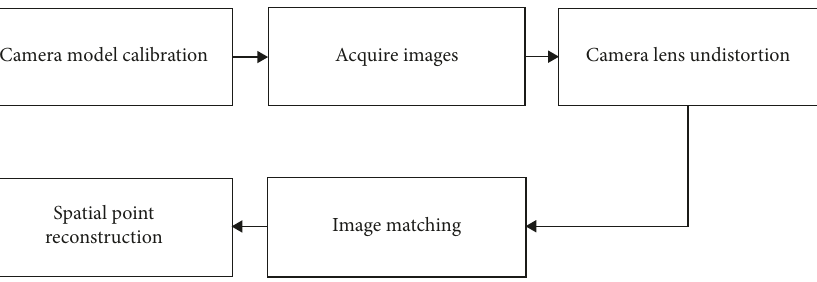
Figure 2: The flowchart of the binocular vision system.